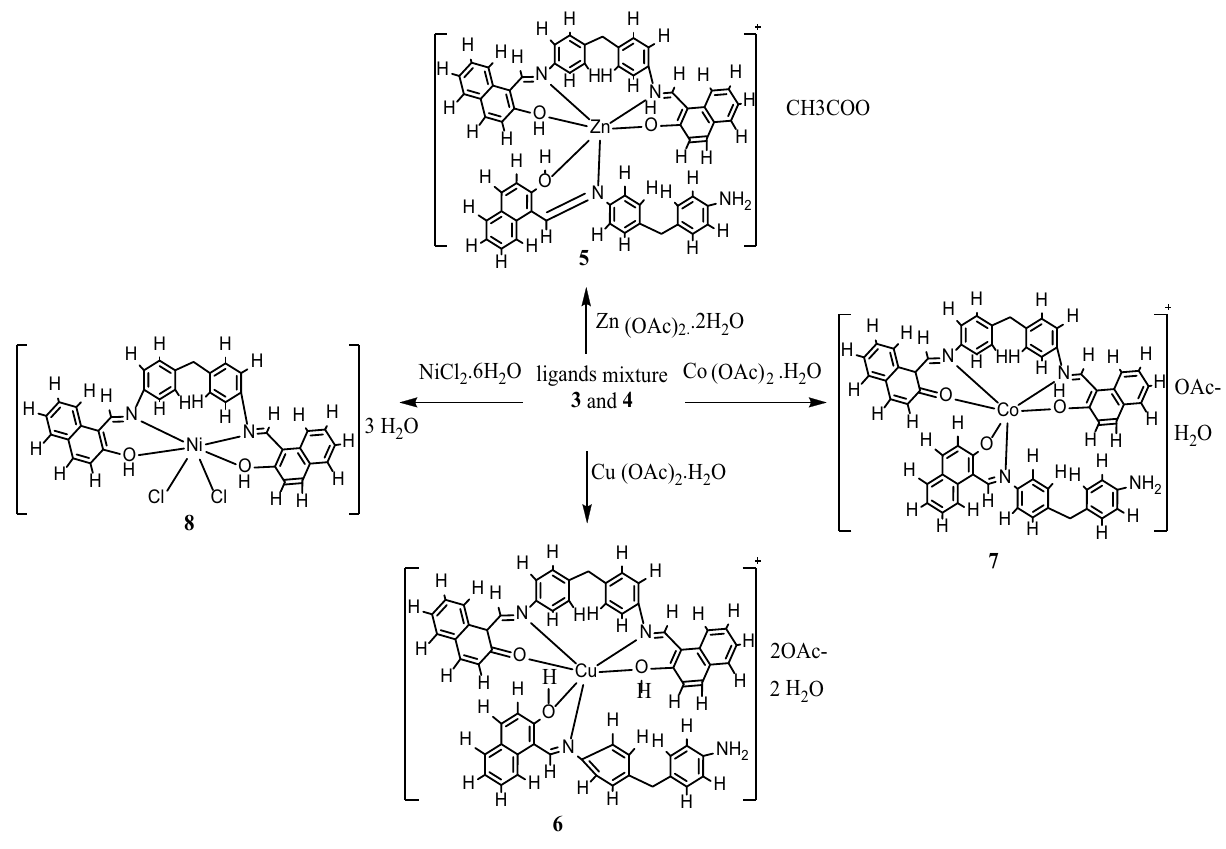
Figure 5. Chemical synthesis of metal complexes